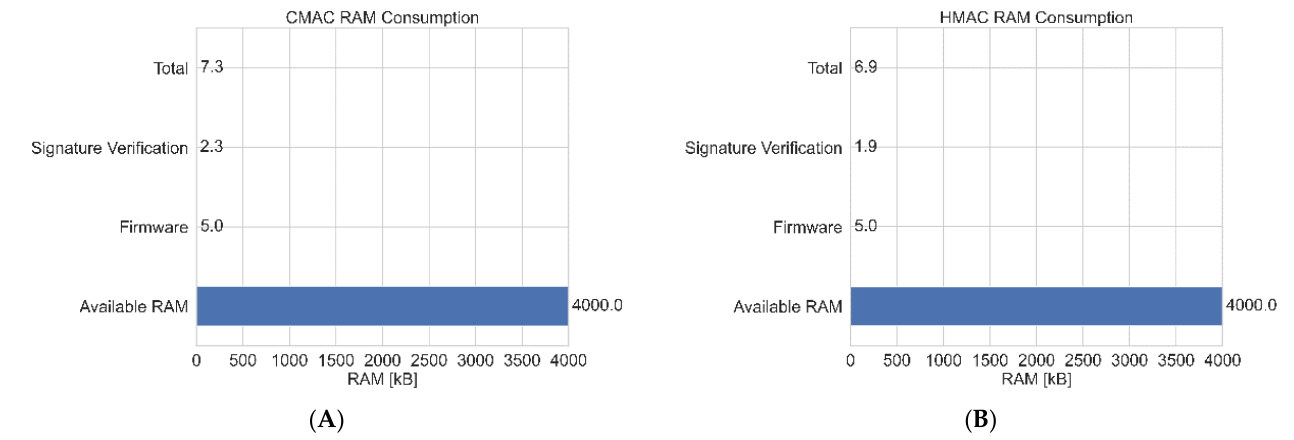
Figure 24. ( A ) CMAC RAM Consumption and ( B ) HMAC RAM Consumption.